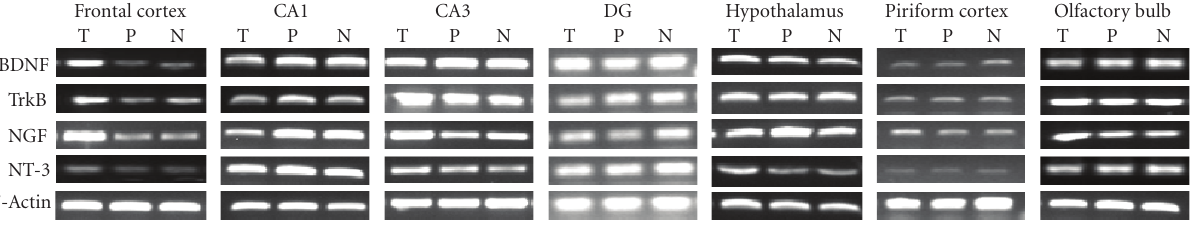
Figure 2: NF mRNA expression in representative gels. T, trained; P, pseudotrained; N,